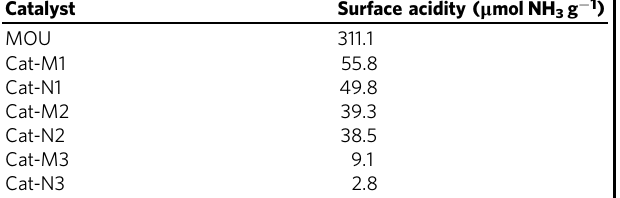
Table 3 Surface acidities of fresh and used catalysts with different reaction cycles under methane and nitrogen.